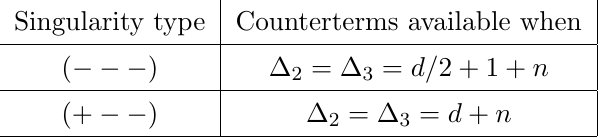
Table 2 . Availability of counterterms for h J (cid:22) 1 O I 2 O I 3 i